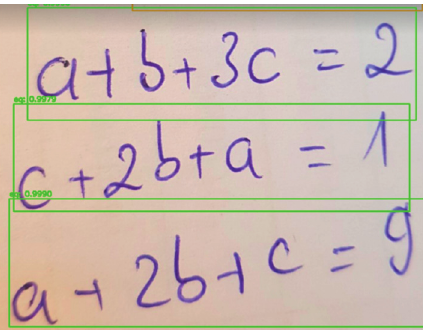
Figure 5: Result of training